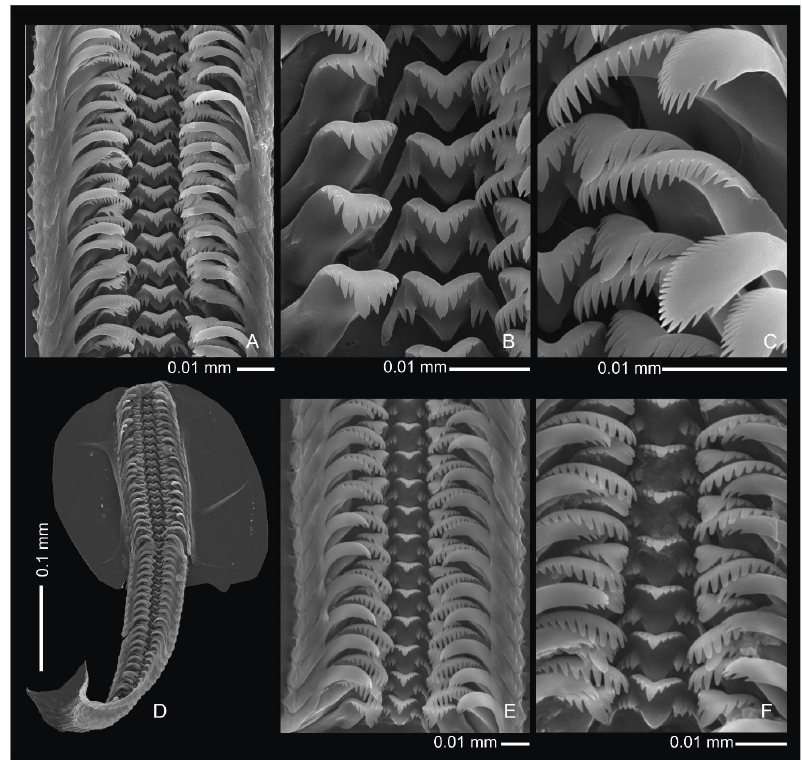
Figure 8. Details of the radula of Clathrocaspia : ( A – D ) — Clathrocaspia laevigata sp. n., from four different specimens from the locality Dag01; ( E , F ) — C . knipowitschii : E — specimen IZAN522_12; F — specimen IZAN522_13, both from the locality Kosh.